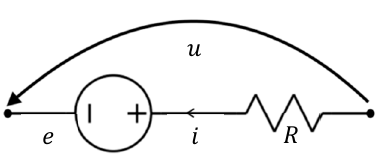
Figure 3. Real voltage source substituting the nonlinear element.